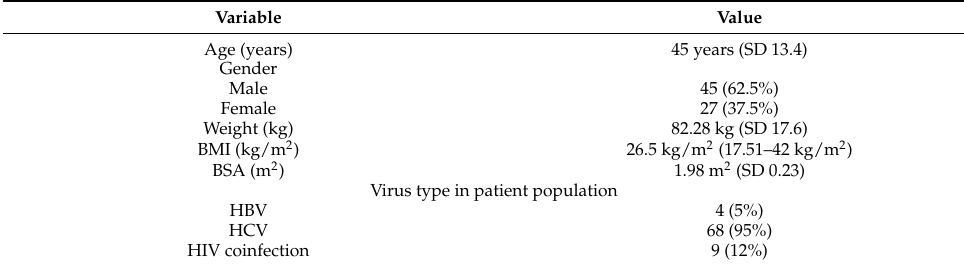
Table 1. Demographic data of study population.